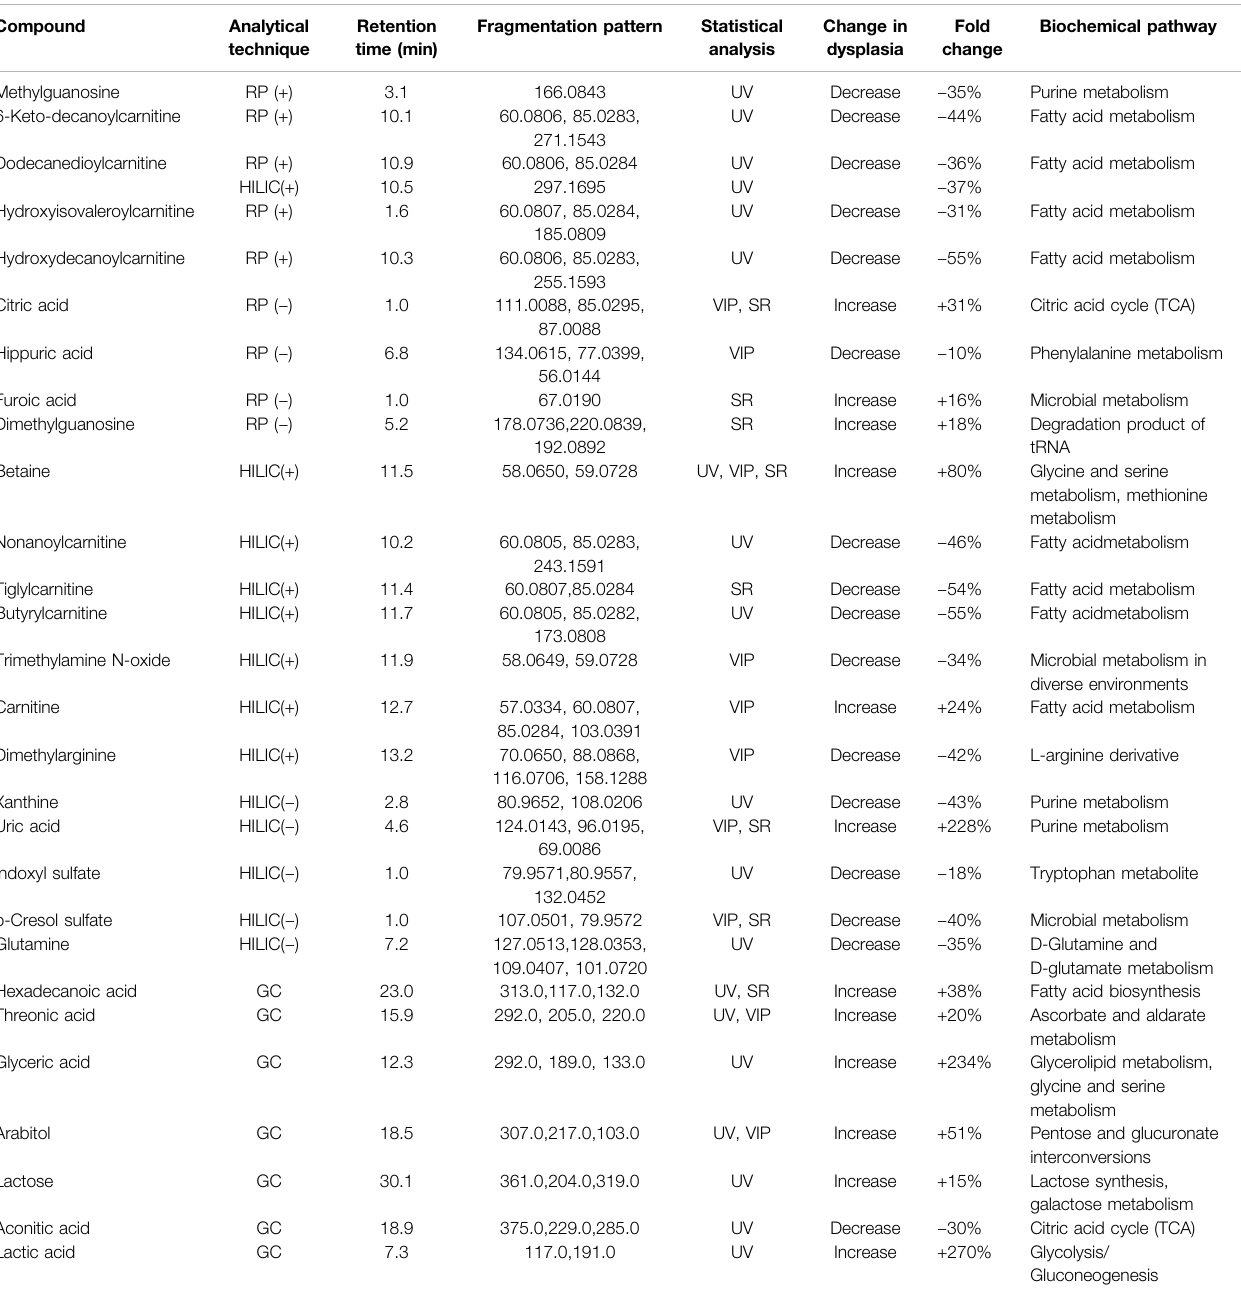
TABLE 2 | Statistically signi fi cant metabolites differentiating patients with renal dysplasia from healthy controls.